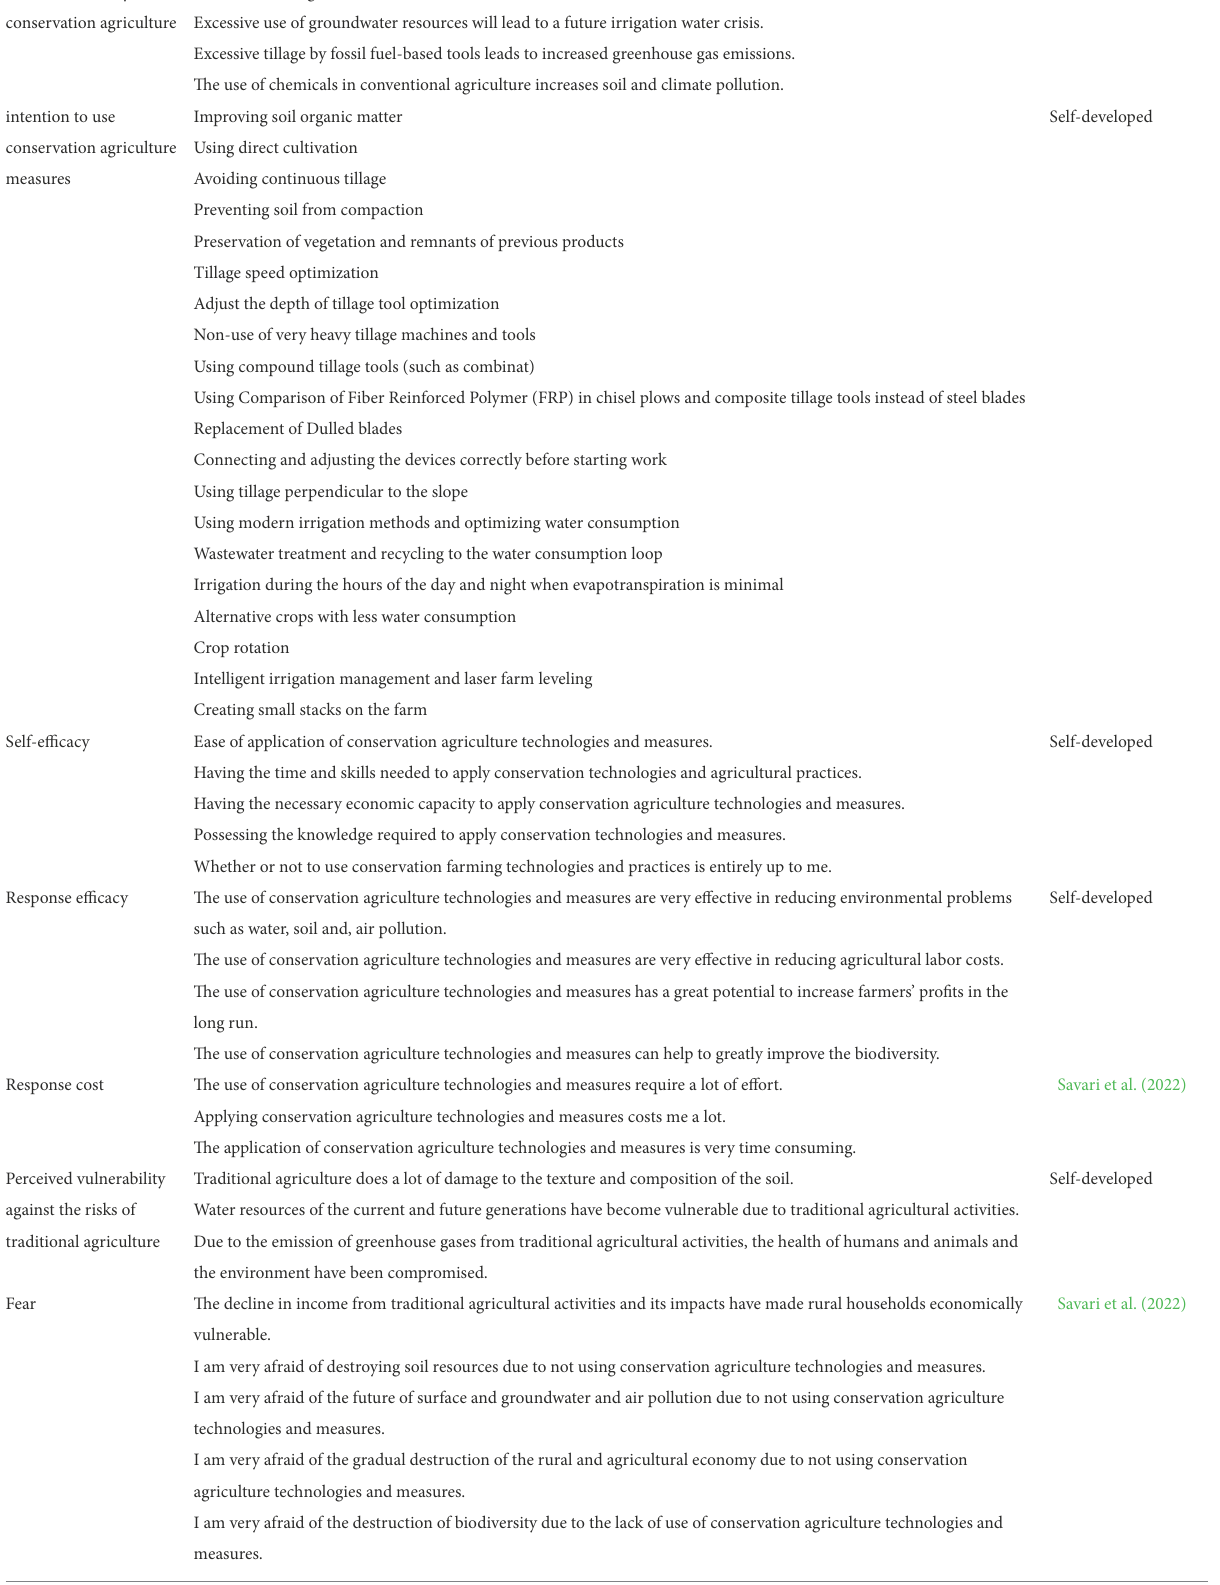
TABLE 1 Details of variables and measuring